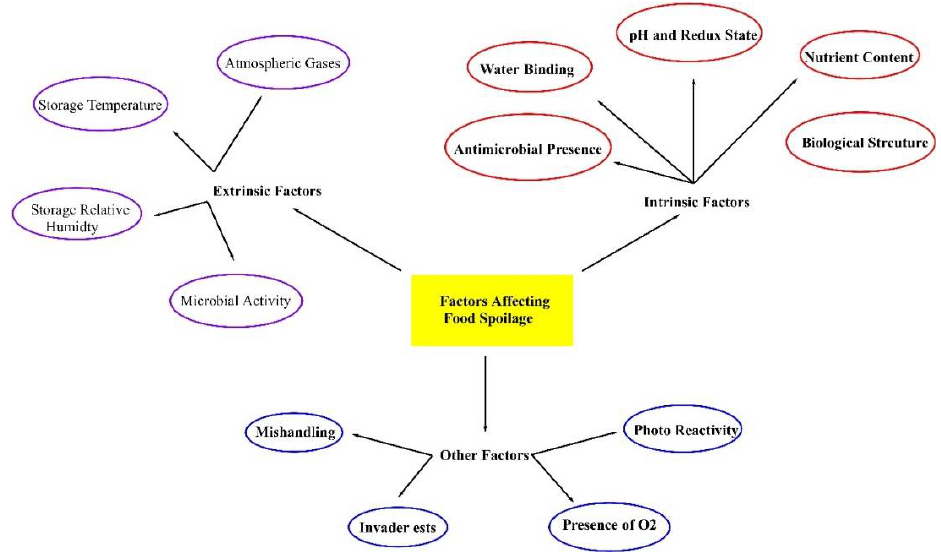
Figure 2. Main factors responsible for food